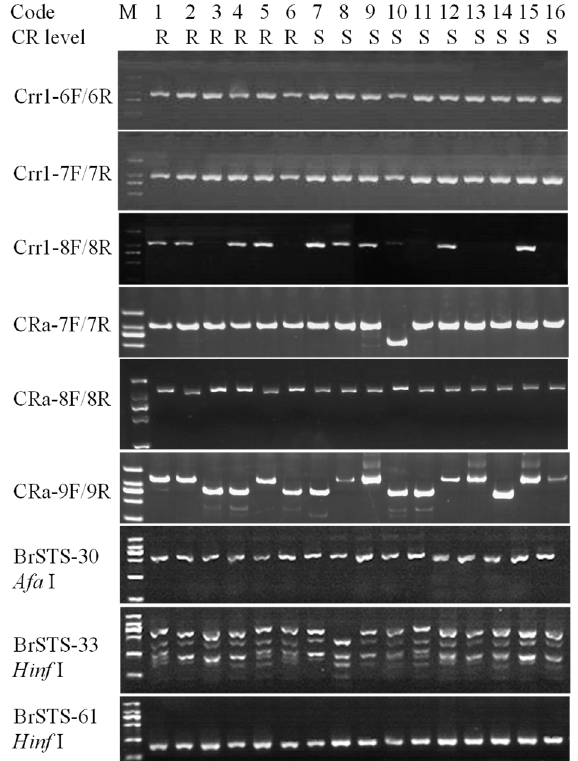
Figure 2. Functional markers for genotyping using six clubroot-resistant lines and ten clubroot- susceptible lines of radish. R and S indicate clubroot-resistant and clubroot-susceptible lines, respec- tively. M: DNA marker. Bands indicate 2000 bp, 1000 bp, 750 bp, 500 bp, 300 bp, 200 bp, and 100 bp from top to bottom. Codes 1–16: CR-79, CR-59, CR-60, CR-88, CR-75, CR-78, CR-4, CR-6, CR-35, CR- 34, CR-28, CR-10, CR-12, CR-19, CR-22, and CR-23.